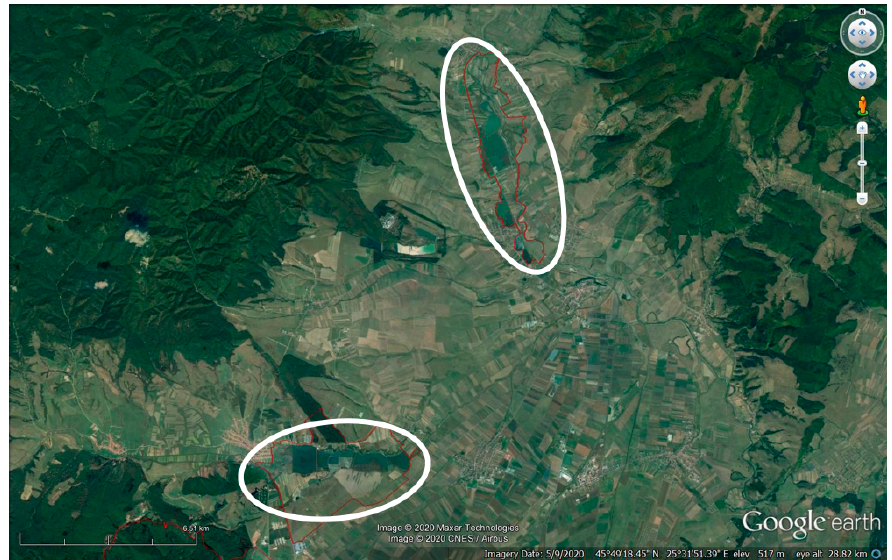
Figure 2. Detail of study area. Dumbr ă vi ț a (bottom) and Rotbav wetlands (white ovals) within ROSPA0037 (red border).